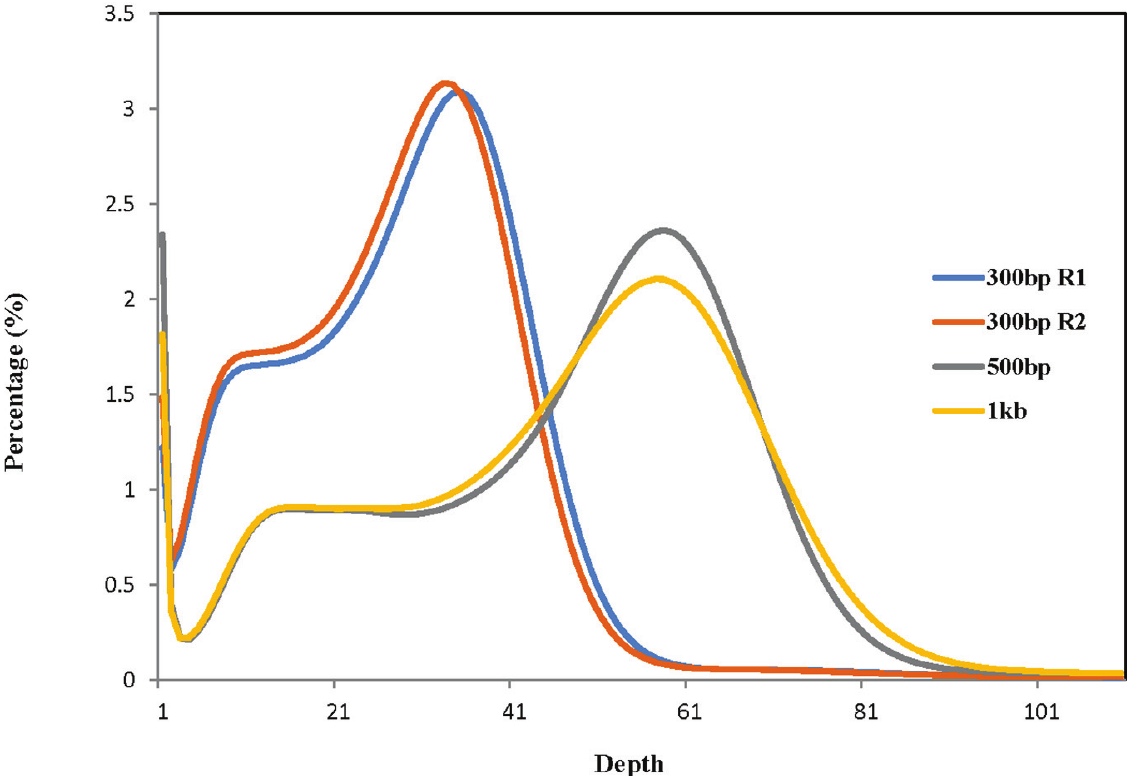
Figure 1. Distribution of unique k-mer depth. The depth of k-mers (size of 27) was plotted against the frequency at which they occurred. Unique k-mers were identified from left (R1) and right (R2) paired-end reads from the library with insert size of ~300 bp, and from all paired-end reads from libraries with insert sizes of 500 bp and 1 Kb, respectively. The peak of the k-mer depth distribution was 35, 33, 58 and 57, respectively. The left smaller peaks indicated a certain degree of heterogeneity of the materials used for genome sequencing of B. tabaci